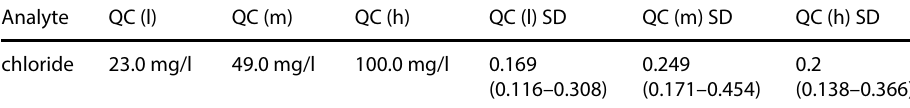
Table 2 Accuracy from QC samples in the validation